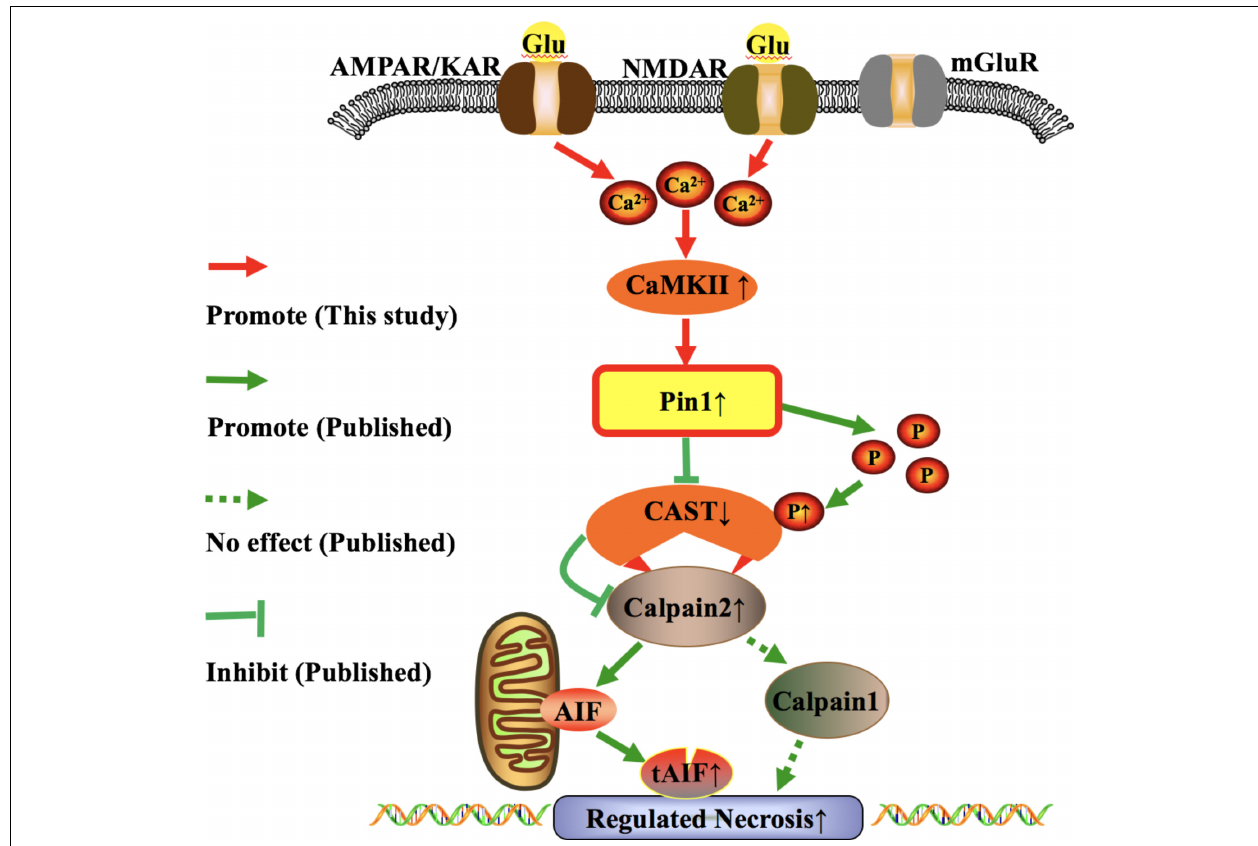
FIGURE 9 | Possible molecular pathway underlying the effect of glutamate in RN of retinal neurons. The role of iGluRs-CaMKII-Pin1-CAST/calpain pathway induced by excessive glutamate in RN of retinal neurons.